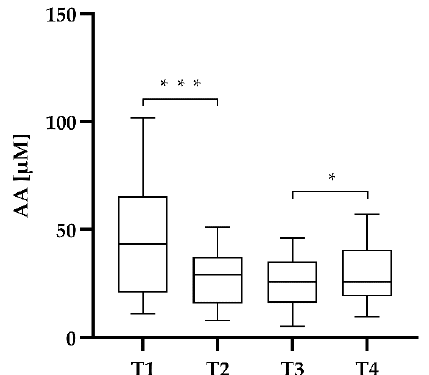
Figure 2. AA plasma concentrations of study group during hospitalization. Plasma samples were collected at four di ff erent time points: preoperatively (T1), first day after surgery (T2), third day after surgery (T3) and on the day of discharge from hospital (T4). * p < 0.05 and *** p <